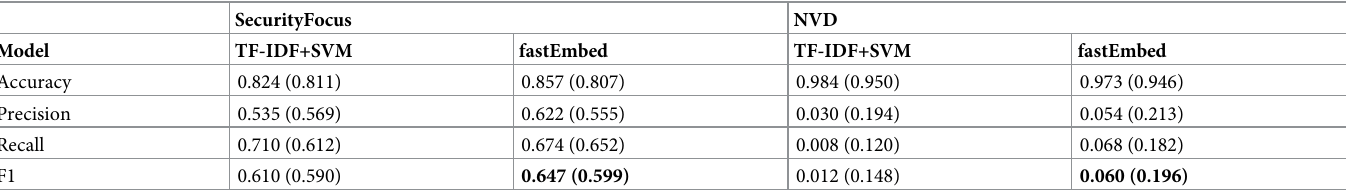
Table 6. Performance comparison of baseline model and fastEmbed of splitting training and test sets temporally.